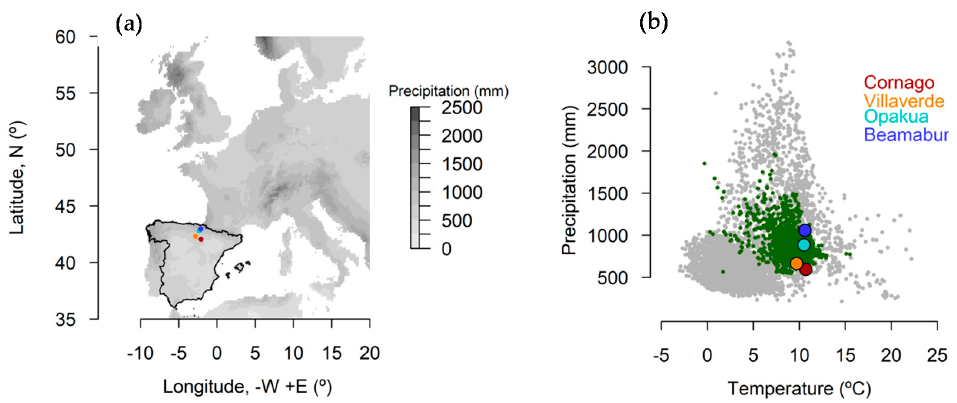
Figure 1. ( a ) Location of the four study sites in northern Spain and ( b ) climate niche space of Douglas fir in North America (grey points), Europe (green points) and the four studied sites (color points) based on annual climate data (mean temperature, total precipitation). Note that the Cornago and Villaverde sites are subjected to drier conditions than the Opakua and Beamaburu sites.